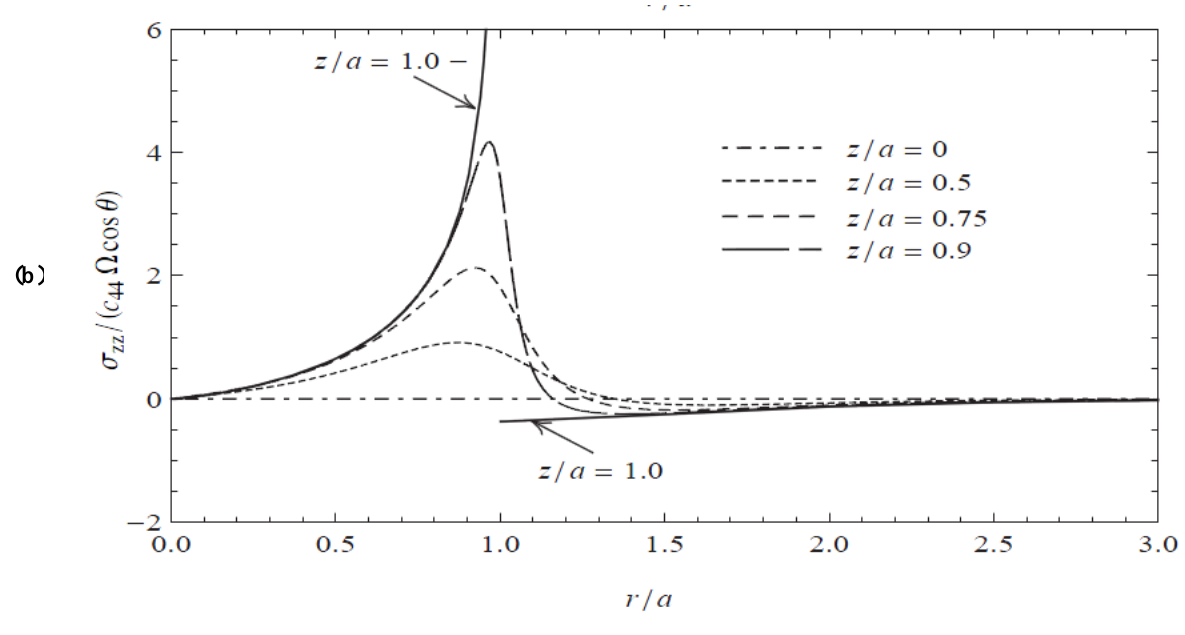
Fig. 4. Normal stress distribution along the radial axis at different depths of a Beryl rock half-space ( s/a=1